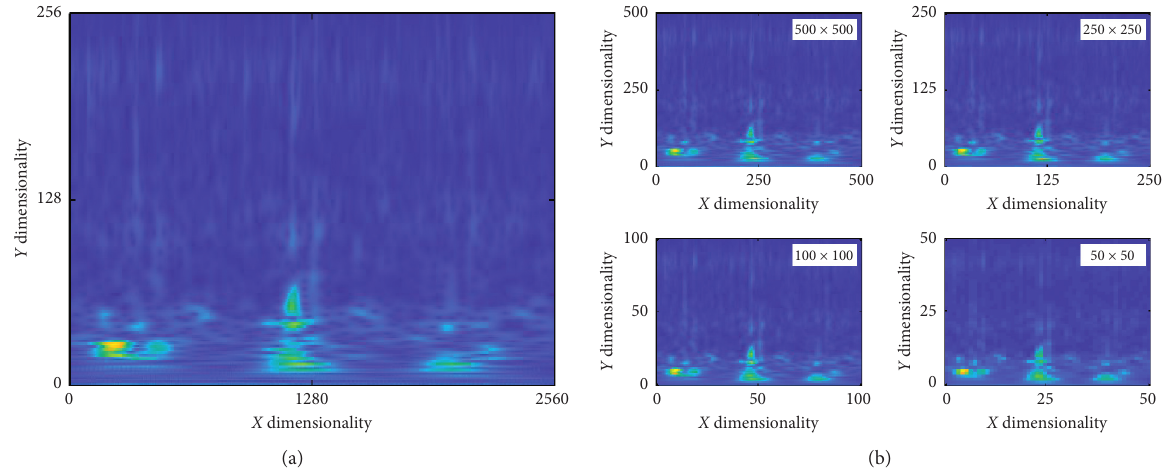
Figure 7: Comparison of dimensionality reduction visualized TFR images with bilinear interpolation. (a) Raw WT-TFR of the last sample of bearing 1_1h. (b) The reduced dimensional